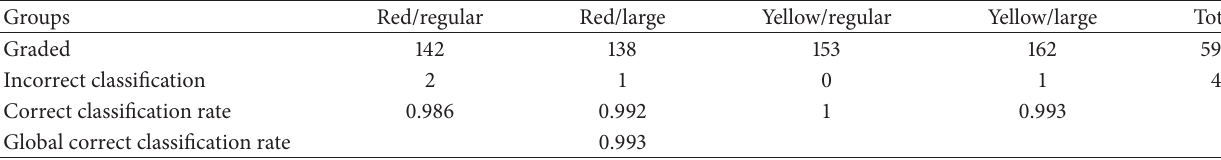
Table 2: Apple classification